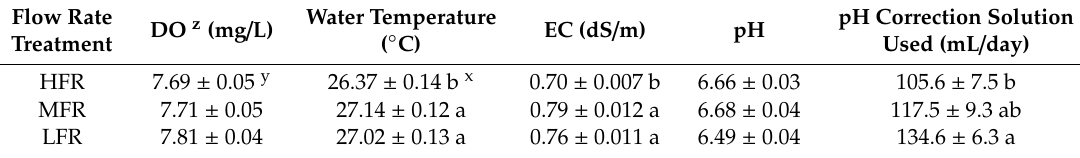
Table 2. Average values of physical and chemical water-quality parameters in fish tank for 4 weeks as a ff ected by high (HFR, 3.3 m / day), medium (MFR, 2.2 m / day), and low (LFR, 1.1 m / day) flow rate. Water Flow Rate DO z (mg / L) Treatment